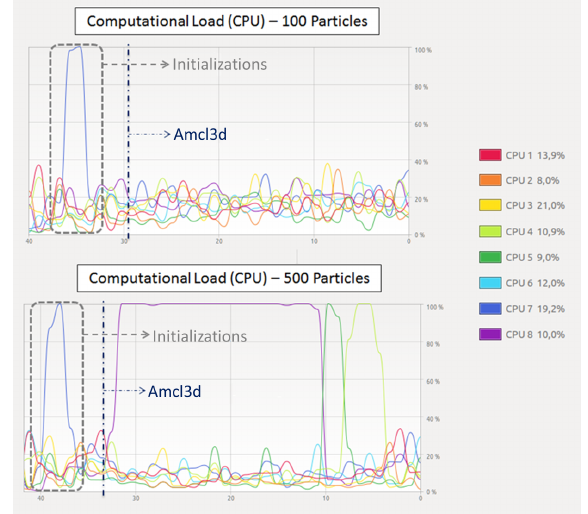
Figure 10. Computational load